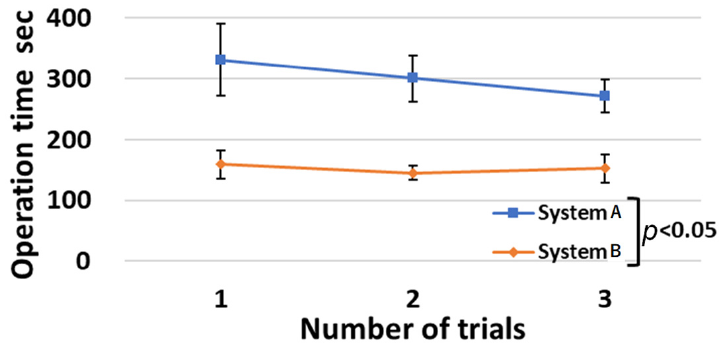
Figure 21. Operation time for each trial of three tasks.